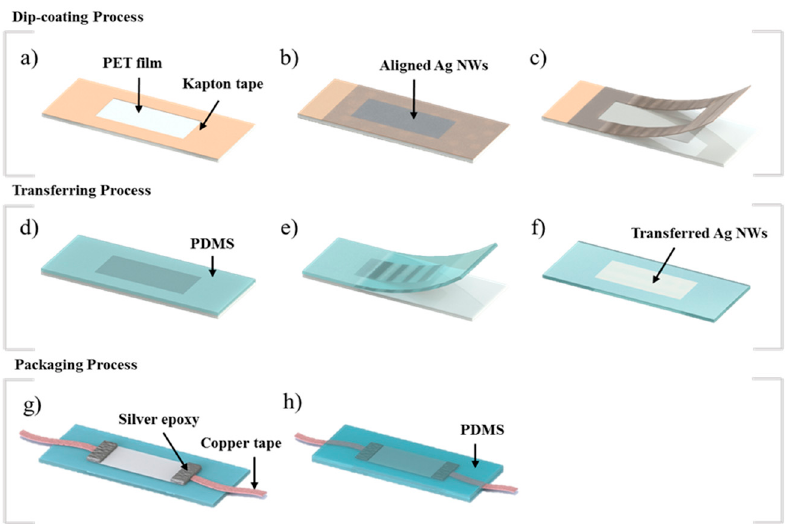
Figure 2. Total process diagram for the flexible strain sensor. ( a ) Forming a pattern on a polyethylene terephthalate (PET) film using Kapton tape. ( b ) Silver nanowire coating using the dip coating process on a patterned PET film. ( c ) Removal of the pattern used as a mask. ( d ) Curing after fabrication of